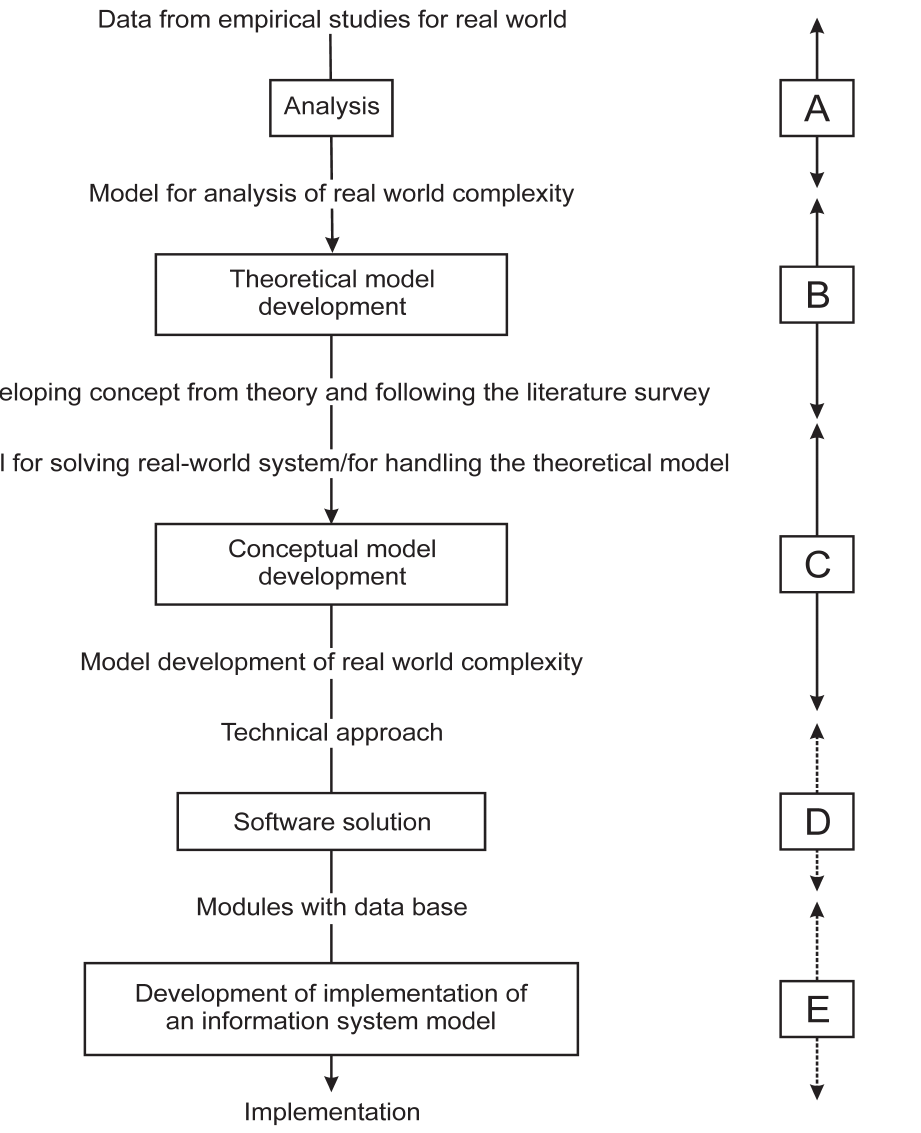
Figure 2. Research design for conceptual model development needed for the real world